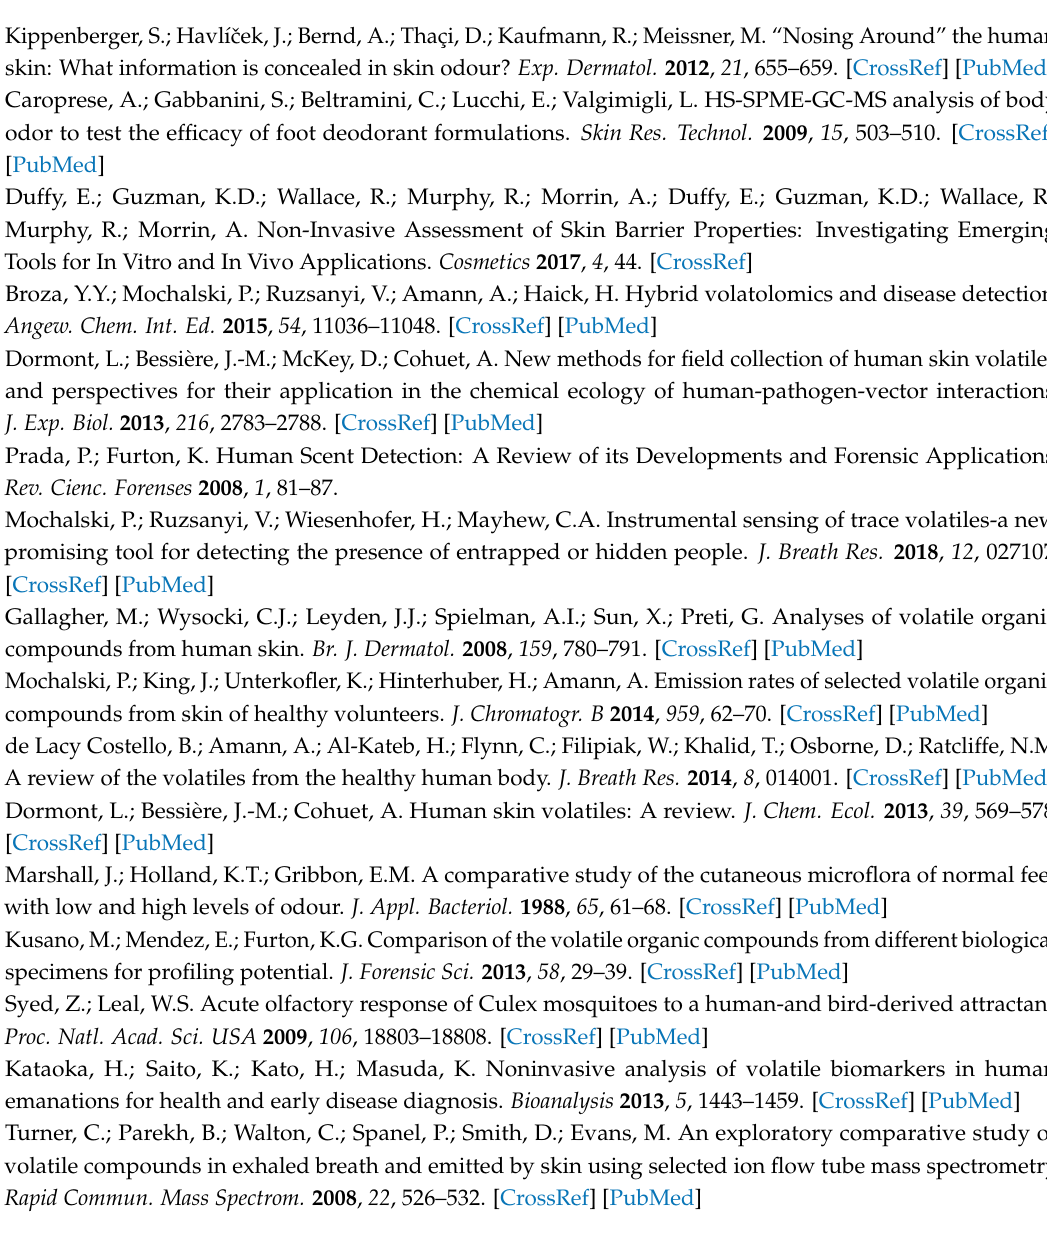
plot comparing intra- and inter-participant variance for n -decanoic acid; Figure S6: Box plot comparing intra- and inter-participant variance for tetradecanoic acid; Figure S7: Box plot comparing intra- and inter-participant variance for n -hexadecanoic acid; Figure S8: Box plot comparing intra- and inter-participant variance for isopropyl palmitate; Figure S9: Box plot comparing intra- and inter-participant variance for squalane; Figure S10: Box plot comparing intra- and inter-participant variance for 6-methyl-5-hepten-2-one; Figure S11: Box plot comparing intra- and inter-participant variance for geranyl acetone; Table S1: Measured tissue dielectric constants for participants’ skin; Figure S12: Participant scent profiles after addition of fragrance to